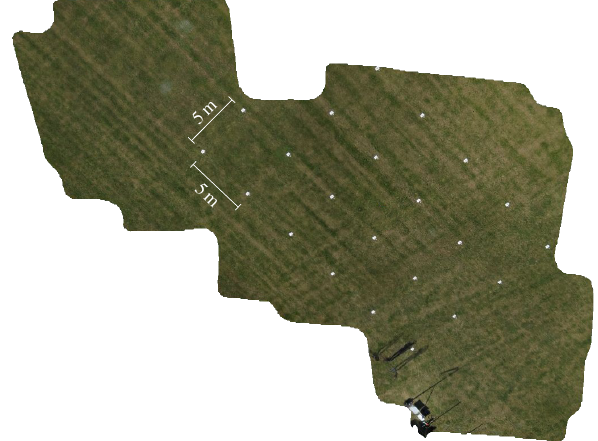
Figure 6: Test area with 24 control points on a model aircraft